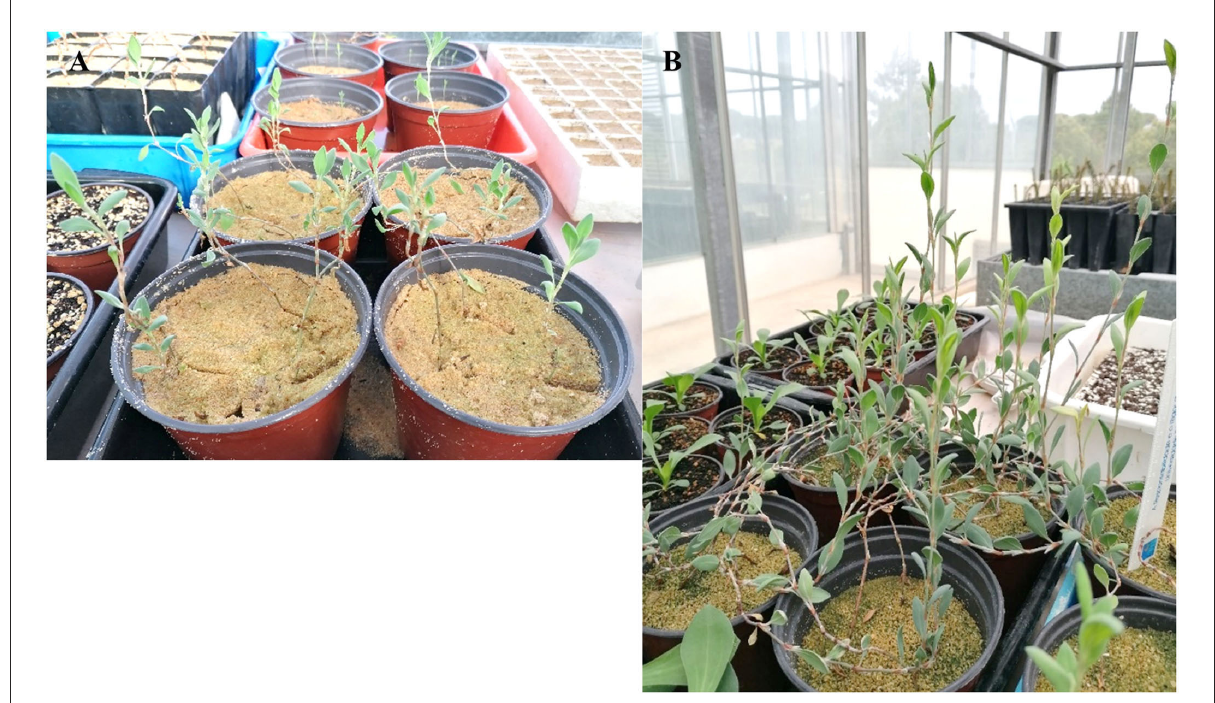
FIGURE5 Sea knotgrass plants after 30 days of acclimatization (A) and after 90 days in the greenhouse (B)